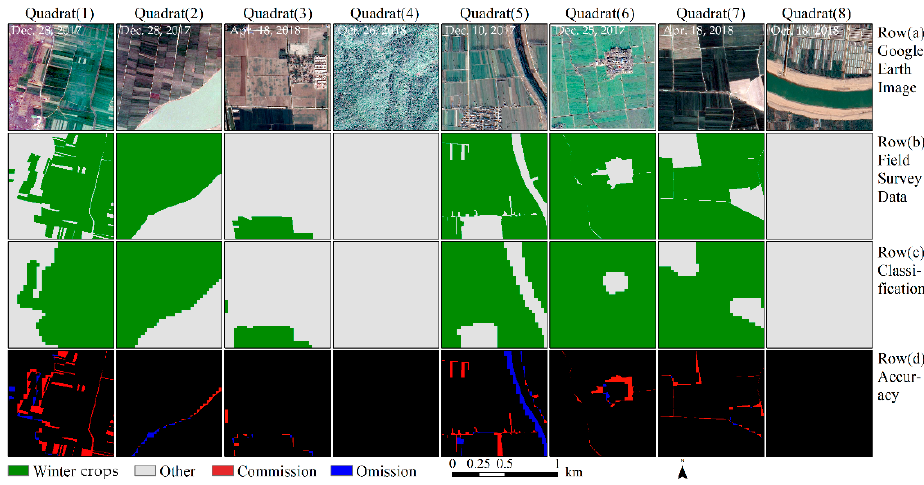
Figure 8. Accuracy assessment of winter crop classification results, based on the composited image of the study area. The eight blocks were selected randomly from 62 validation blocks. Row (A): The Google Earth image, with a spatial resolution of 1 m. Row (B): The ground truth data, with a spatial resolution of 3 m. Row (C): The extracted winter crops, using the methods proposed in this study. Row (D): Accuracy assessment. Black indicates correct classification, red indicates commission errors, and blue indicates omission errors for winter crop classification.